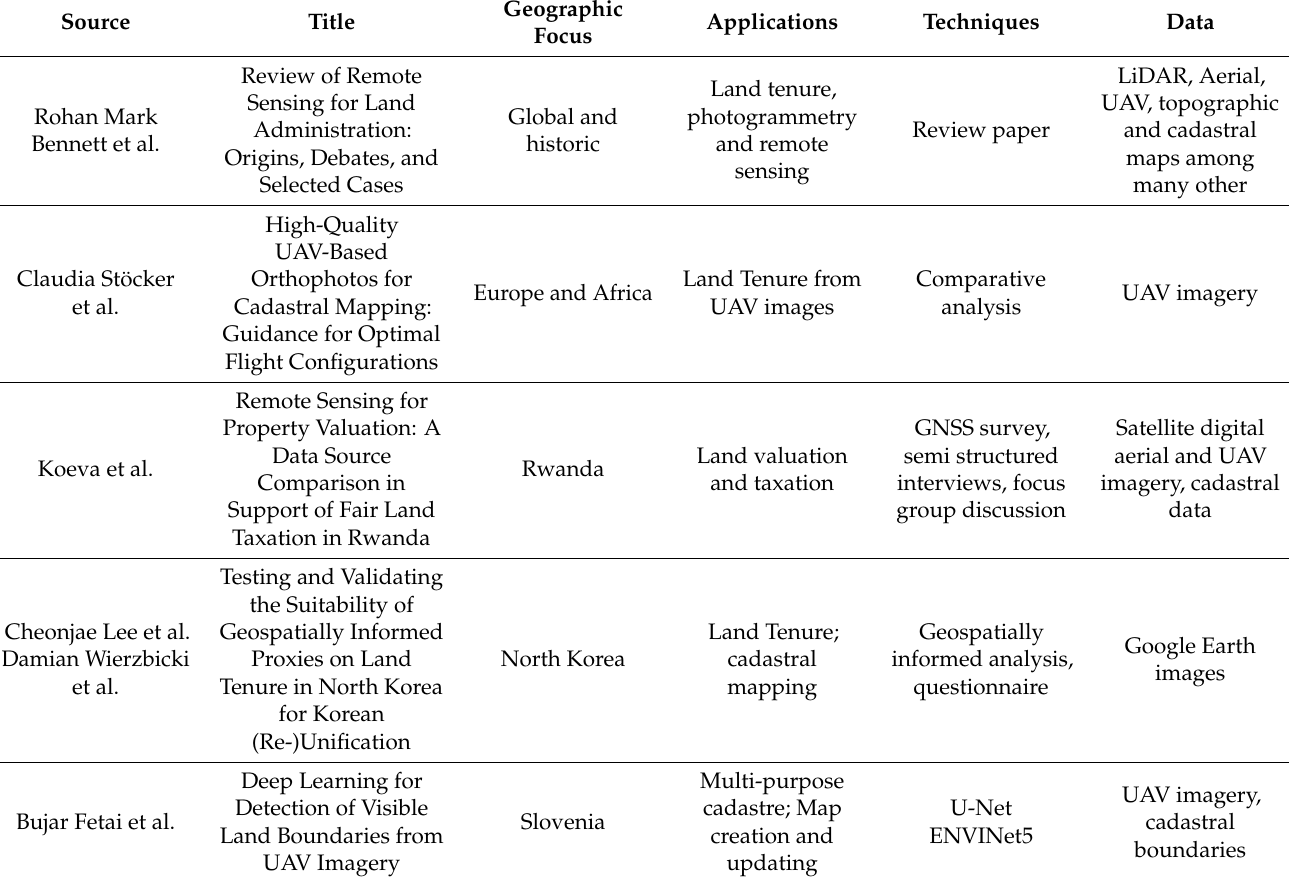
Table 1. Remote sensing applications for LA presented in this